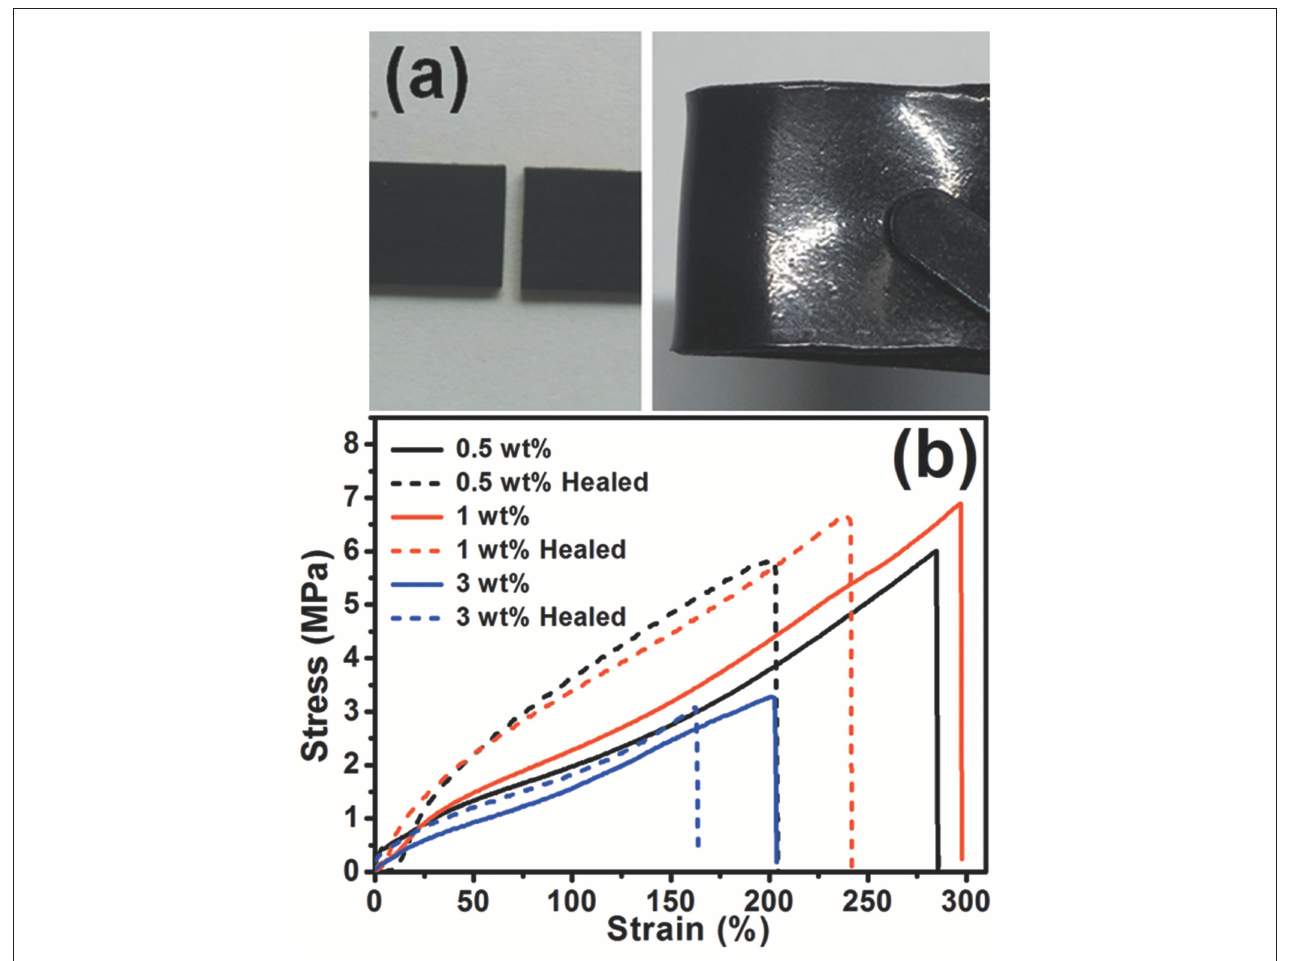
FIGURE 7 | (a) Photographs of fractured and healed hGnP/epoxy with 1 wt% GnP. (b) Typical stress-strain curves of original and healed hGnP/epoxy